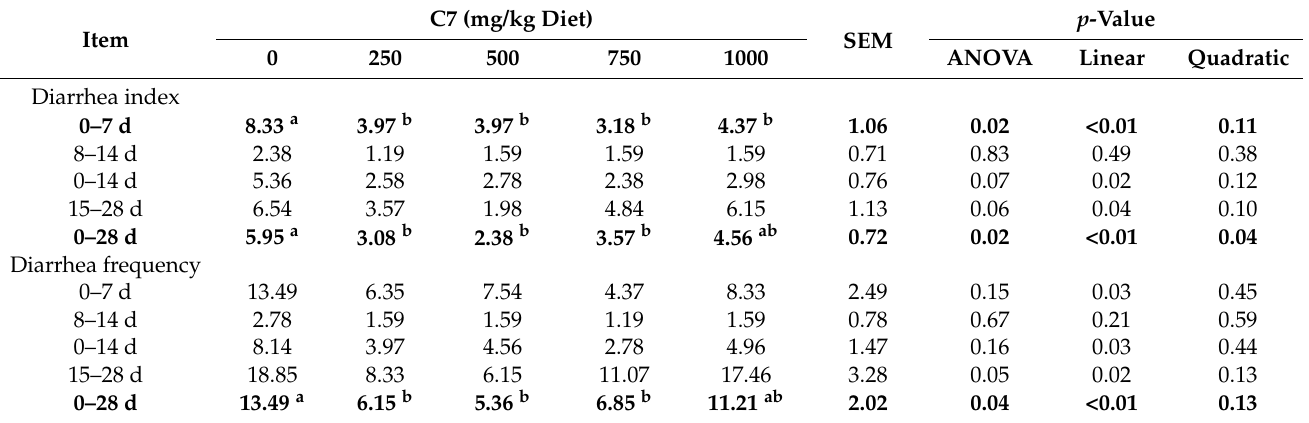
Table 6. Effects of dietary C7 supplementation on the diarrhea incidence of weaned piglets (%).